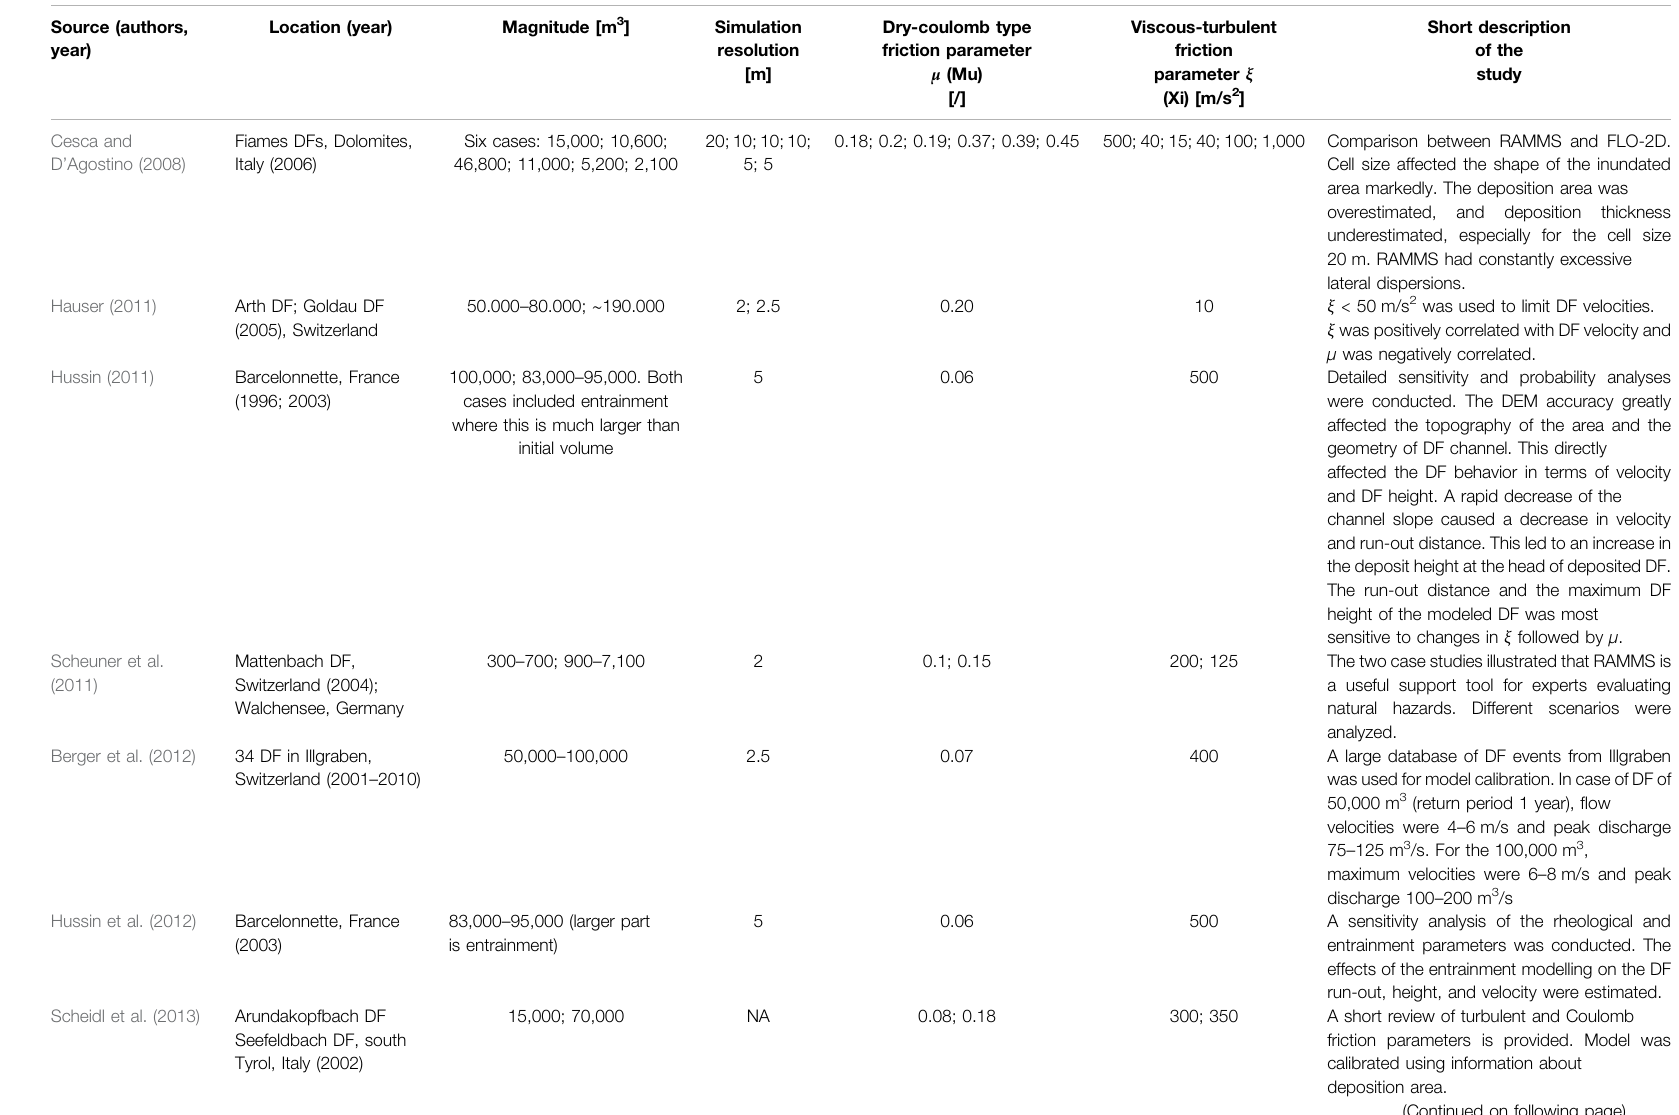
TABLE 1| Areviewofdebris fl ow(DF) andGlacial Lake OutburstFlood (GLOF) modellingusingRAMMS software andits debris fl owmodule. Studiesaresorted bythepublication year ofthesource, andthen inalphabetical order. NA indicates that the information was not provided in the cited reference. Multiple parameters are shown when combinations of these parameters were used.